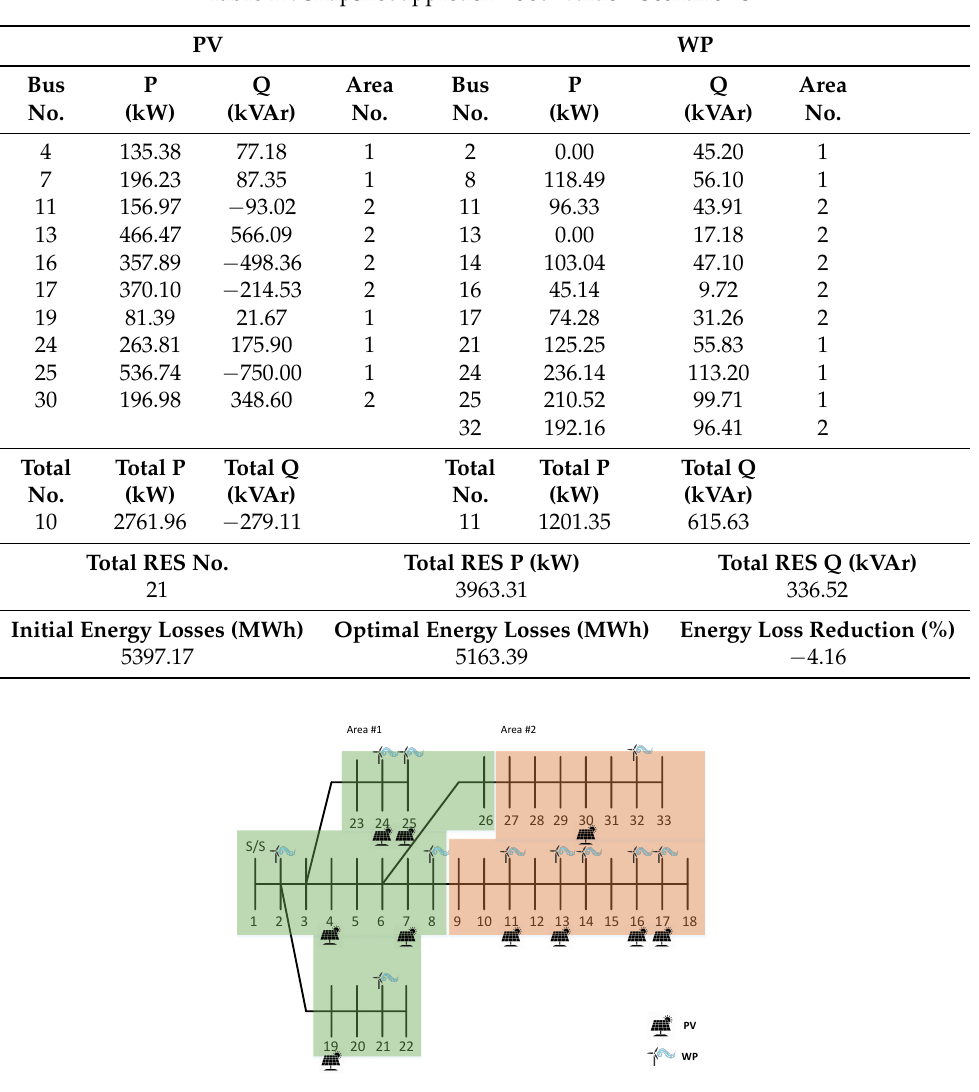
Figure 27. Snapshot Approach—50% Value—Scenario #3